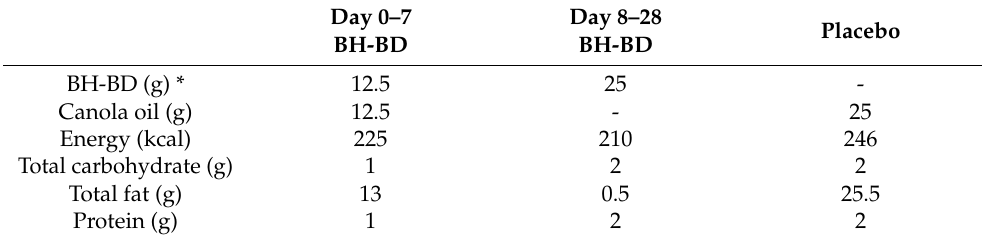
Table 1. Nutritional information of Study